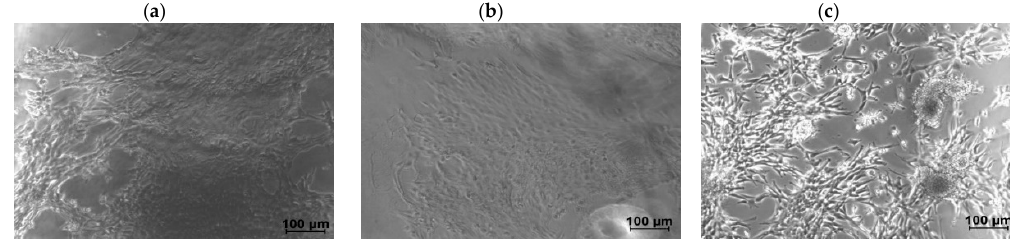
Figure 7. Phase-contrast images of NIH/3T3 fibroblasts after six days of culture on a 2% CHI/0.2% CNF composite hydrogel. ( a ) Cells cultured on original top hydrogel surface; ( b ) cells cultured on freshly cut hydrogel surface; ( c ) cells cultured without hydrogel (control).